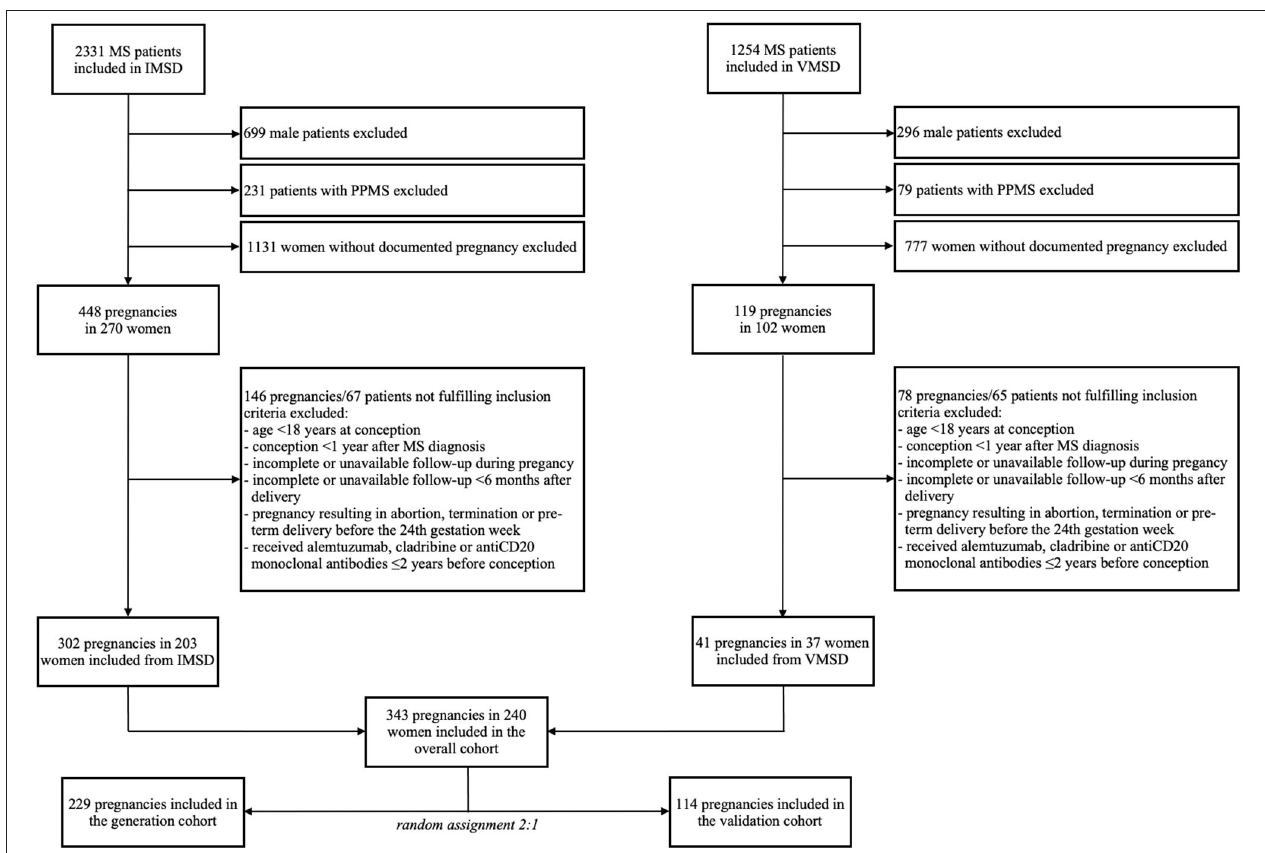
FIGURE 1 | Inclusion and randomization flowchart. IMSD, Innsbruck multiple sclerosis database; MS, multiple sclerosis; PPMS, primary progressive MS; VMSD, Vienna MS database.